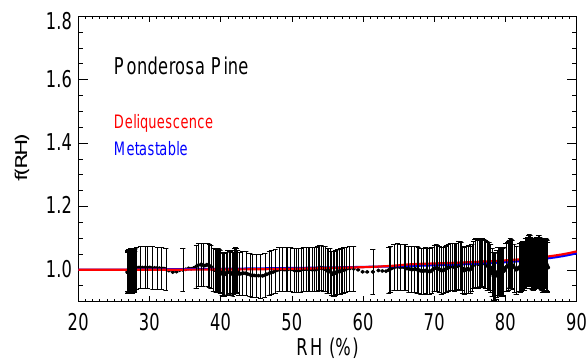
Fig. 4. Measured and modeled humidification factors ( f (RH)) as Figure 4. Measured and modeled humidification factors ( f (RH)) as a function of relative a function of relative humidity (RH, %) for particles emitted from humidity (RH, %) for particles emitted from ponderosa pine burns. The f (RH) results ponderosa pine burns. The f (RH) results derived from the E-AIM derived from the E-AIM model are for deliquescence and metastable equilibrium. model are for deliquescence and metastable equilibrium. Measure- Measurements and model calculations performed at a wavelength of 530 nm. ments and model calculations performed at a wavelength of